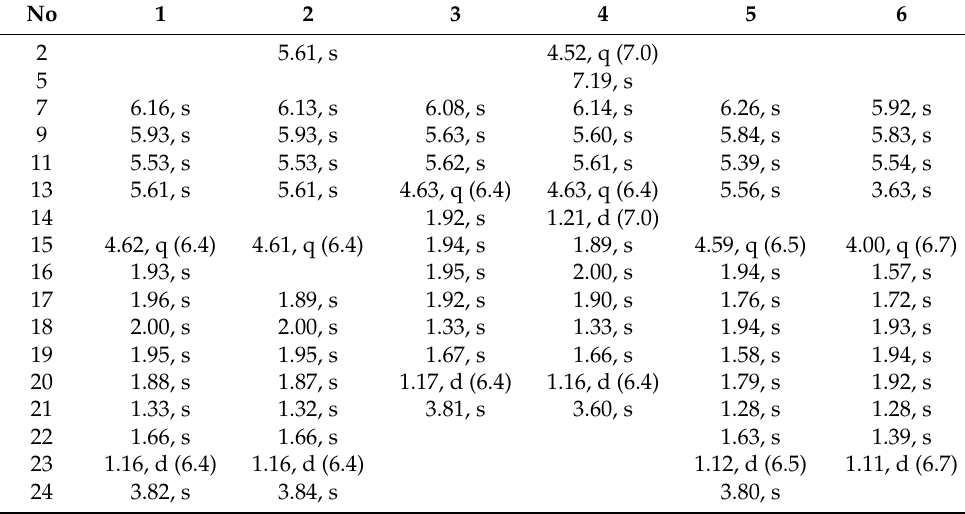
Table 1. 1 H-NMR Data of Compounds 1 – 6 (500 MHz, DMSO- d 6 , δ in ppm, J in Hz).